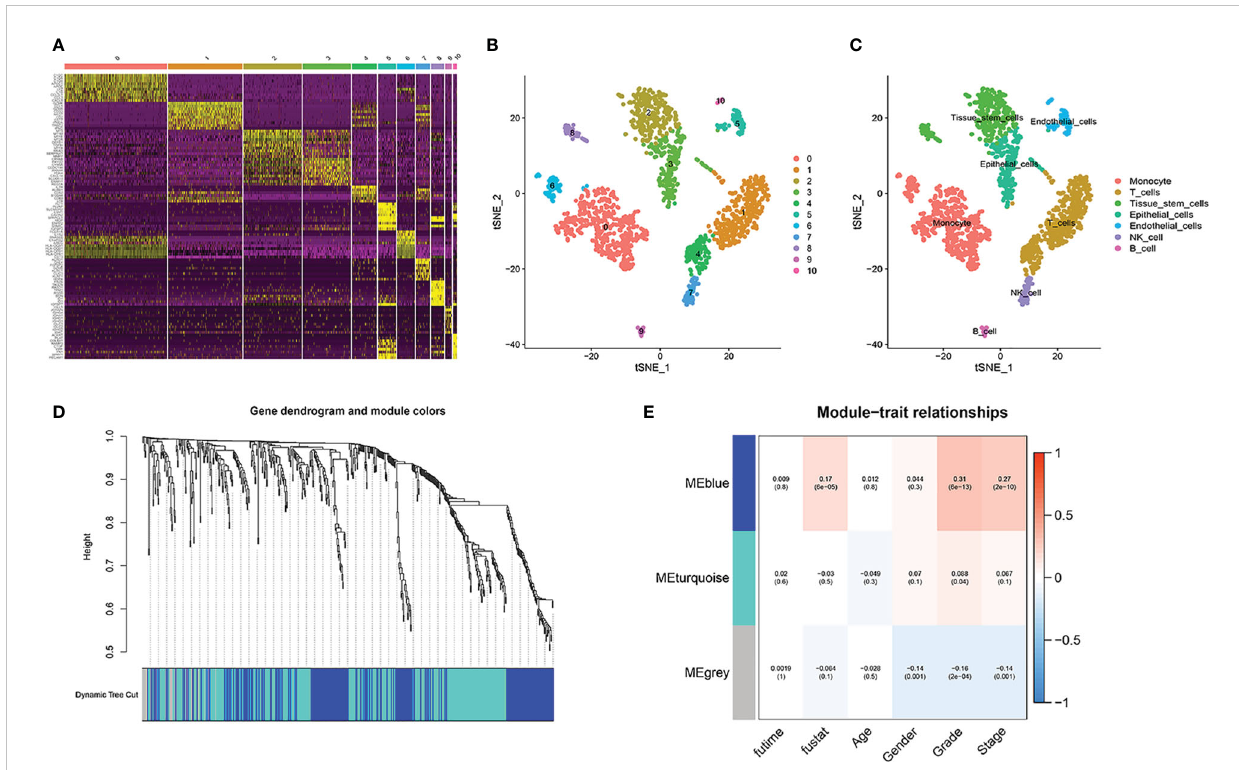
FIGURE 3 Single-cell sequencing analysis. (A) 10 highest expressed genes in each cluster. (B, C) the distribution and annotations of these 11 clusters. (D, E) WGCNA found that MEblue was closely related to the score of survival